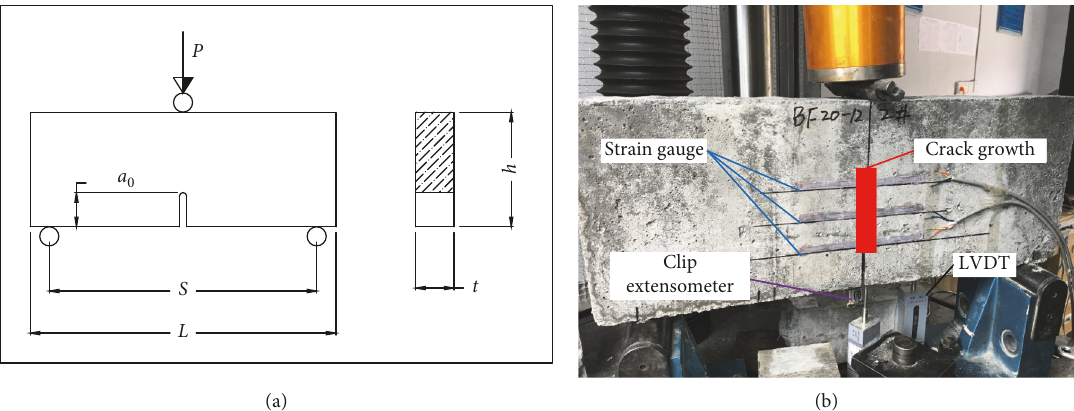
Figure 2: Three-point bending test. (a) Loading diagram. (b) Under test. Note: P is the applied load, L is length of specimen, h is height of specimen, t is thickness of specimen, S is span interval, and a 0 is height of prefabricated